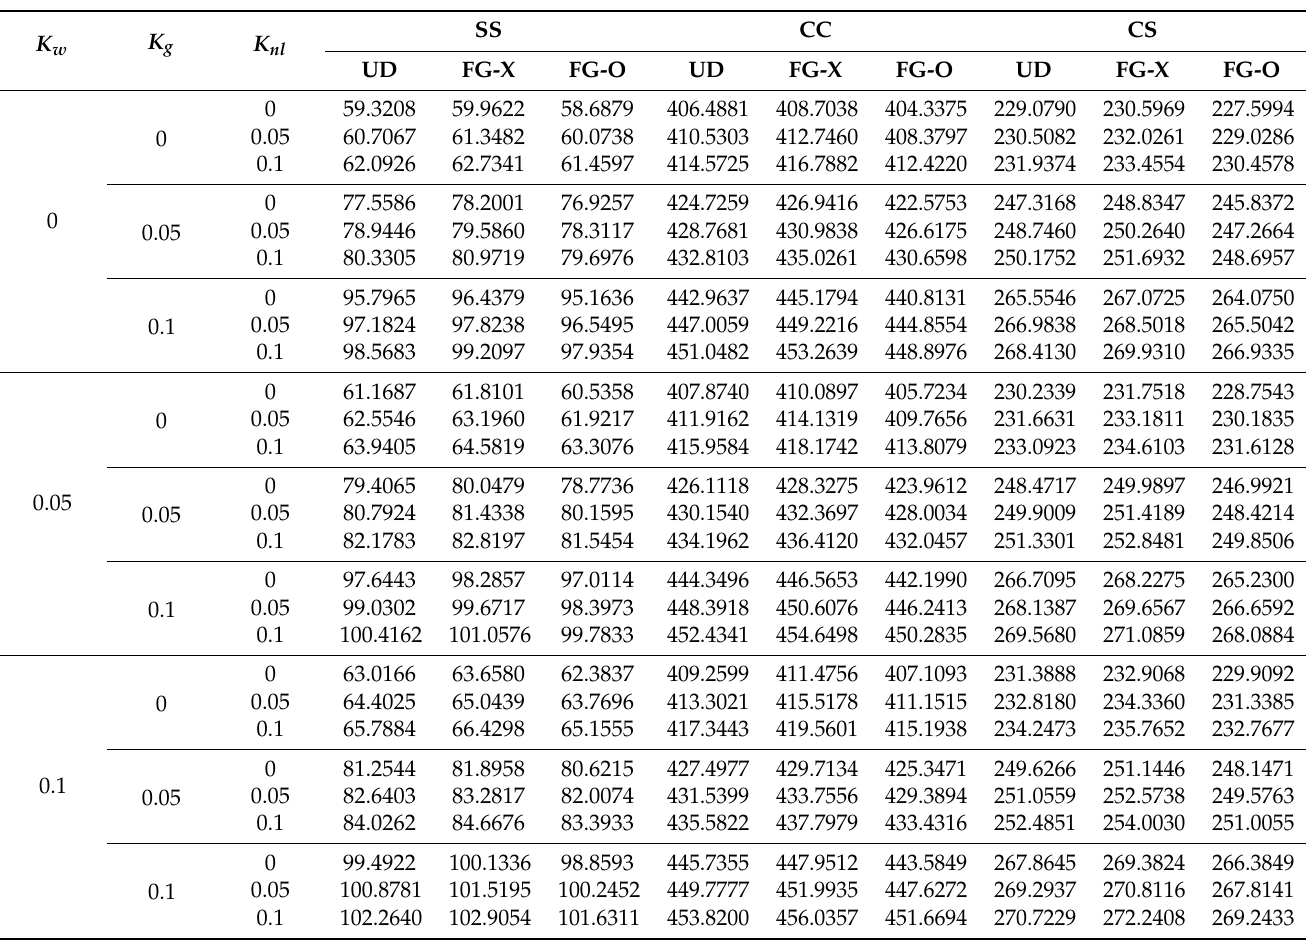
Table 8. Effect of hardening nonlinear parameters on the dimensionless buckling load of CNTRC curved sandwich